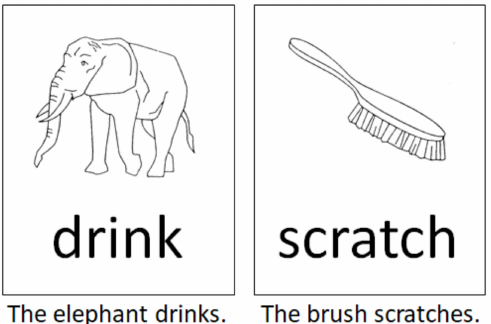
Figure 1. Two examples according to the intraoperative language task used in this study. Subjects and patients were asked to generate grammatically and semantically correct sentences according to the language stimulus as